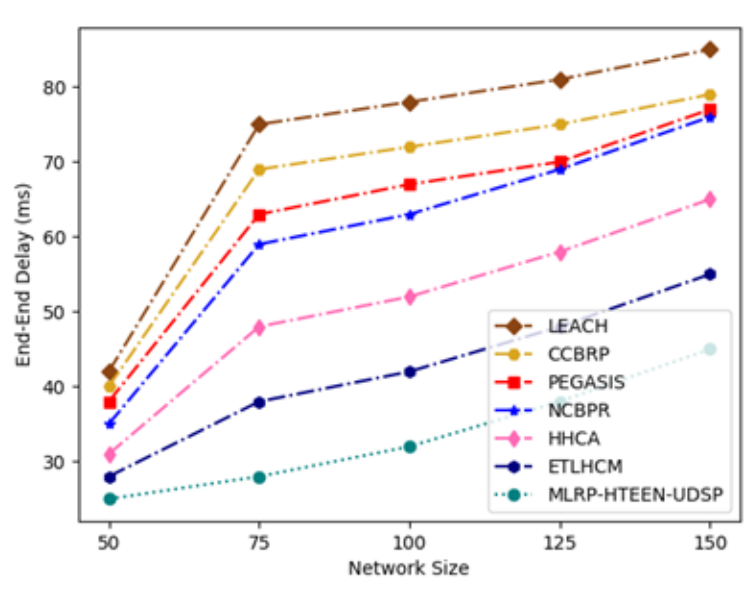
Figure 4. Comparison of end-to-end delay. Throughput is the total packets received by the sink within a specified duration. The comparison of throughput is shown in Table